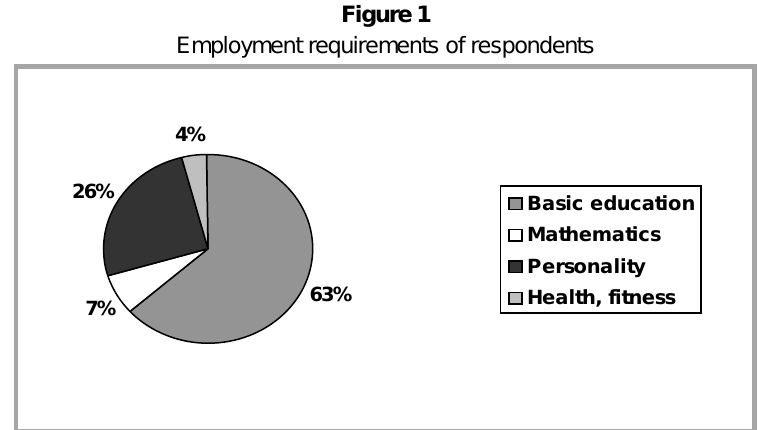
Employment requirements of